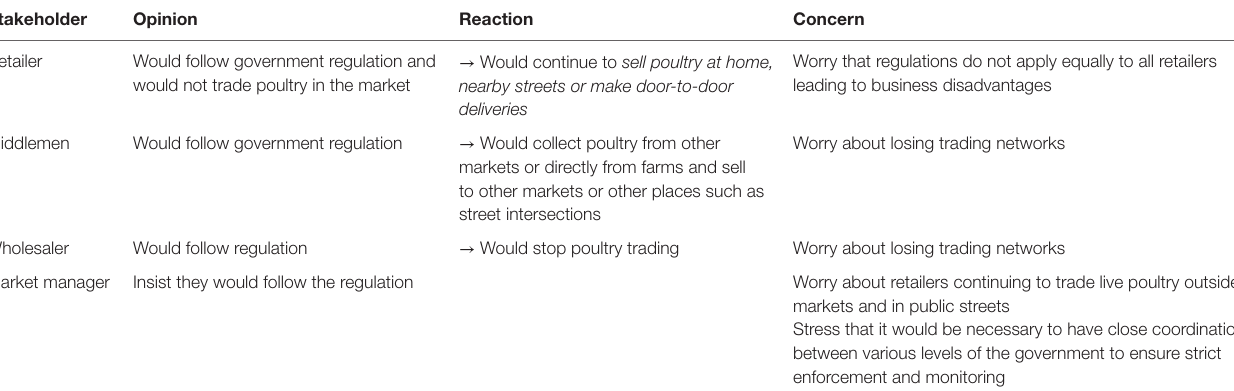
taBlE 2 | Opinion of stakeholders on market closure for a duration of 7